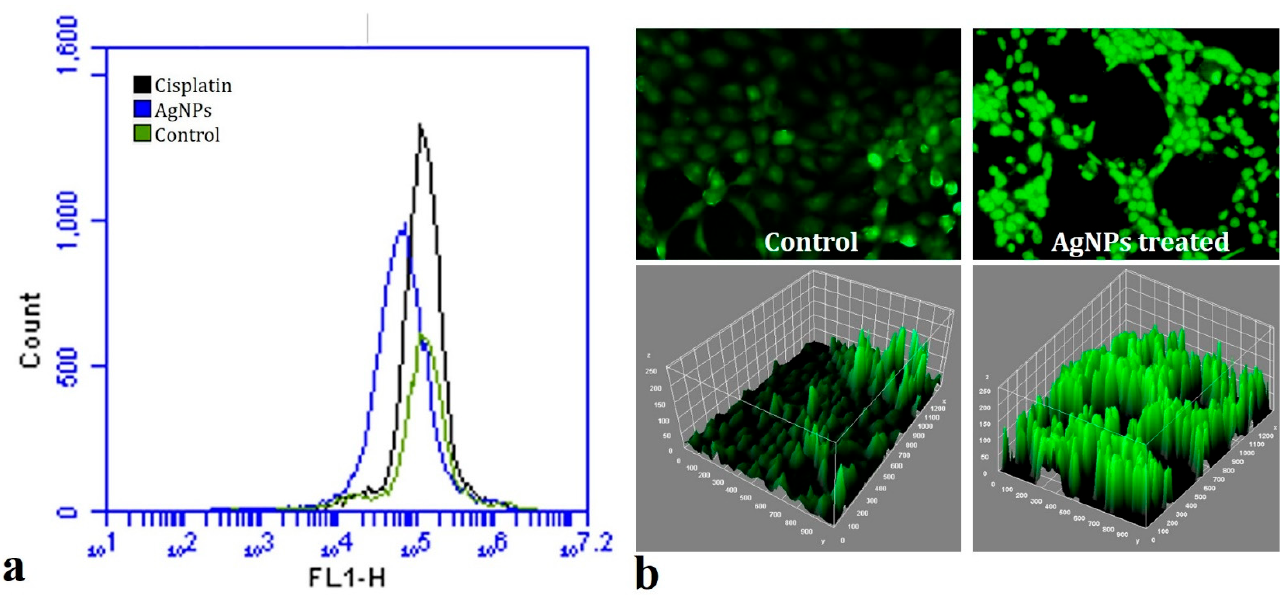
Figure 12. ( a ) Flow cytometric analysis of ROS production (in vitro) in MDA-MB-231 cells after AgNP treatment; ( b ) fluorescence microscopy images of the MDA-MB-231 cells treated with AgNPs analyzed using ImageJ software.